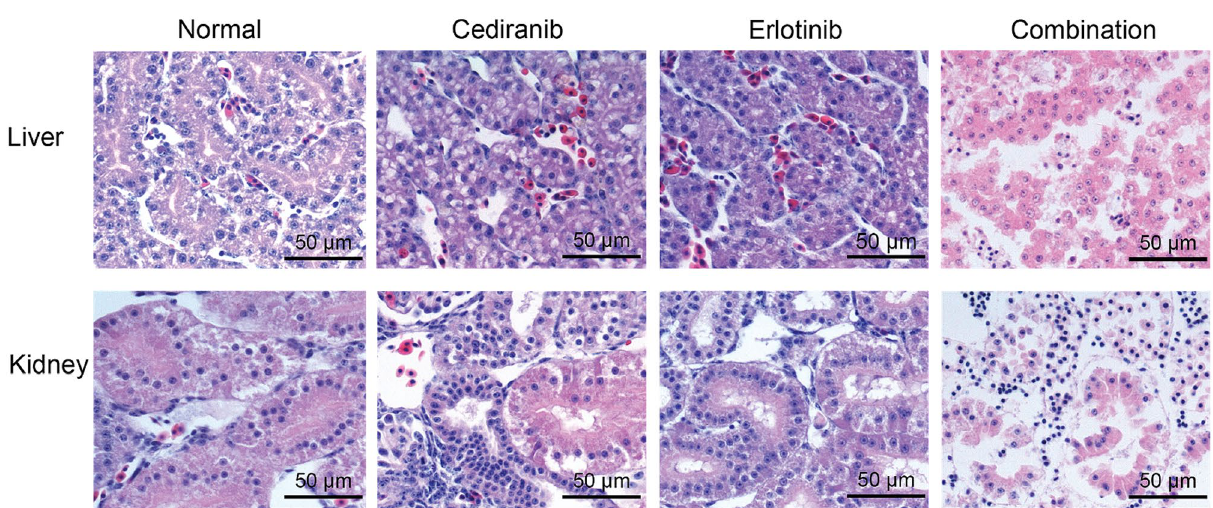
Figure 5. Histology slides stained with H&E of embryonic quail. Comparison of liver and kidney for e10 quail dosed with the human clinical C max of cediranib (VEGFR and poly-kinase inhibitor) and/or erlotinib (EGFR inhibitor) revealing synergistic toxicity in liver and